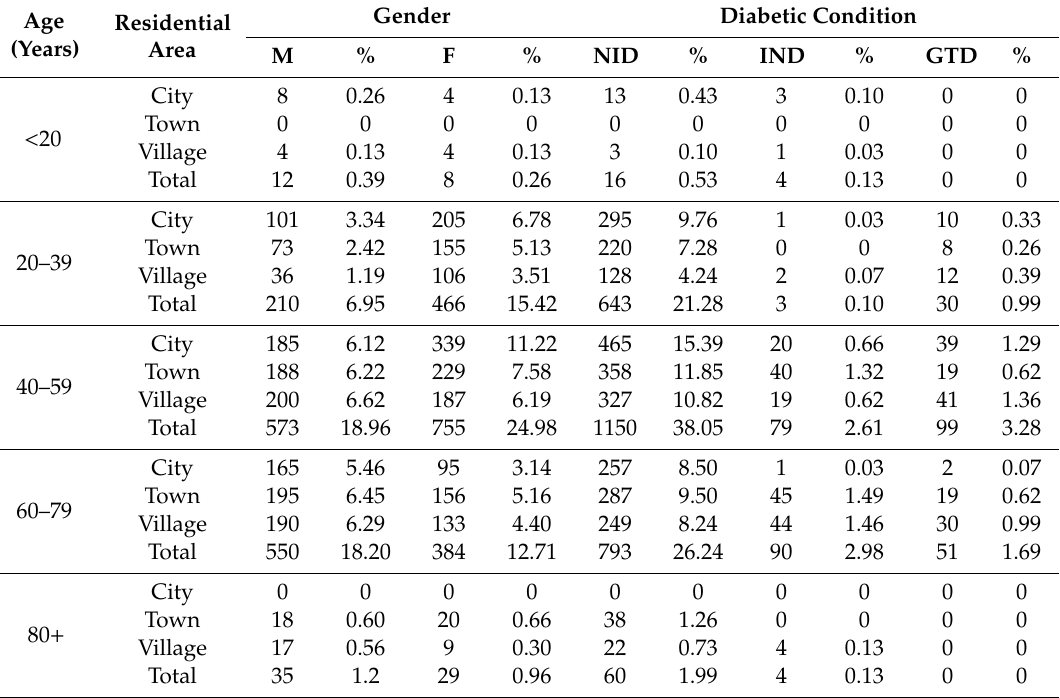
Table 2. Diagnosed diabetes cases stratified by age, gender, residential area and diabetic conditions.